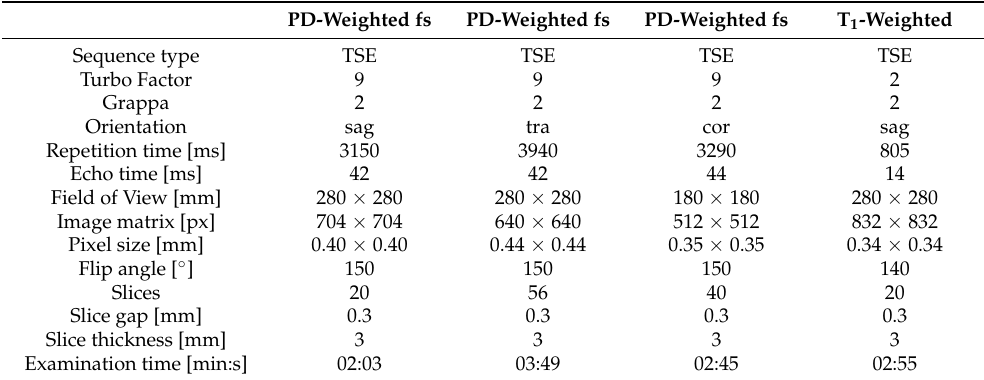
Table 5. Imaging sequences and their parameters used in combination with the 1 H foot/ankle coil for clinical standard examination. PD-Weighted fs PD-Weighted